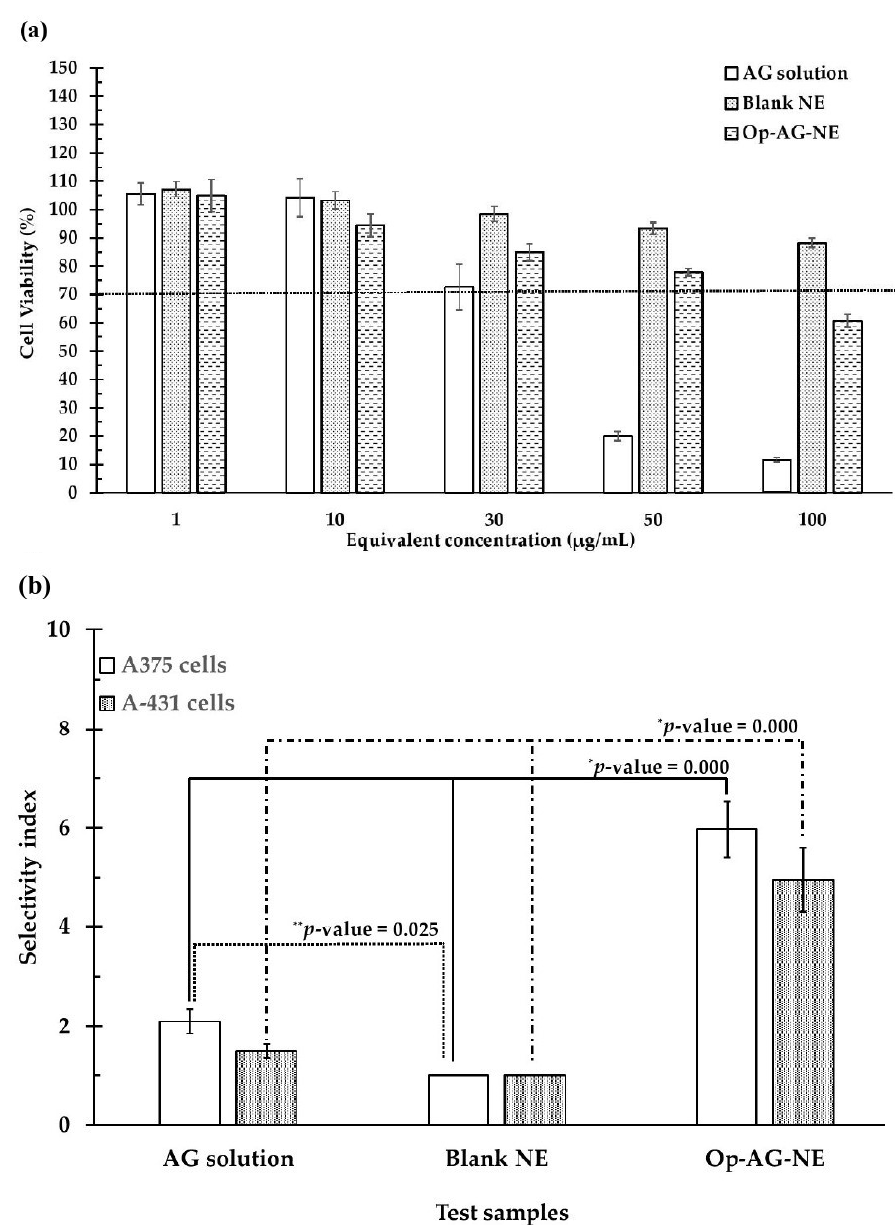
Figure 5. ( a ): Cell viability (%) of the HFF-1 cells; ( b ) Selectivity index of AG solution, Blank NE and Op-AG-NE in the A375 and A-431 cells (mean ± SD, n = 3) (* and ** represent significant difference at p -values < 0.05 for the comparison of selectivity index of AG solution in the cells and that of Op-AG-NE, and for the comparison of selectivity index of AG solution in the cells and that of Blank NE, respectively).